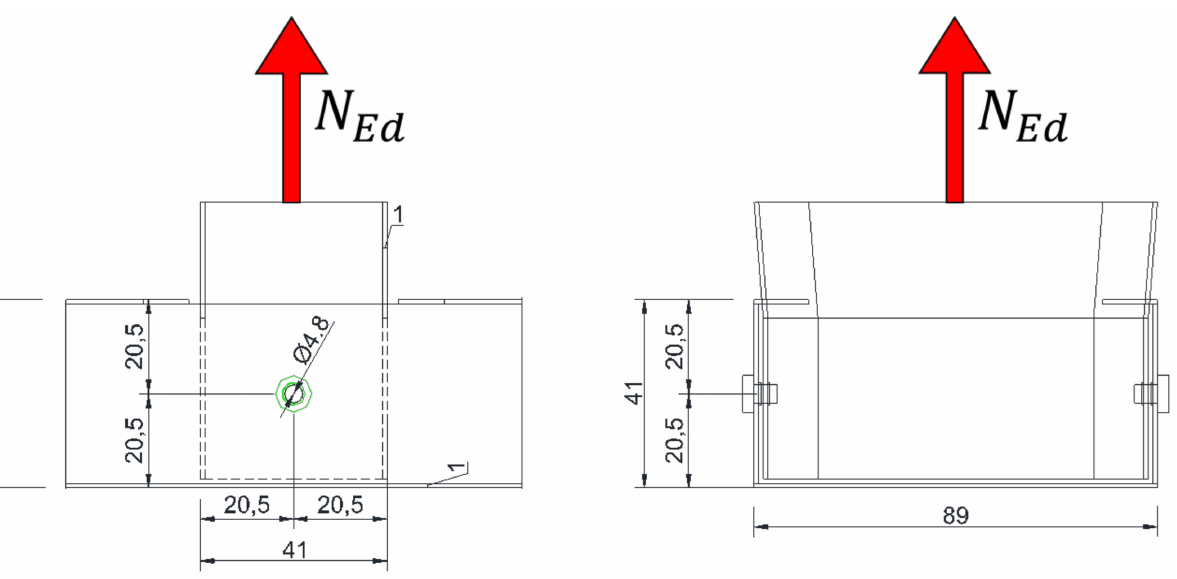
Figure 40. Joint A geometric